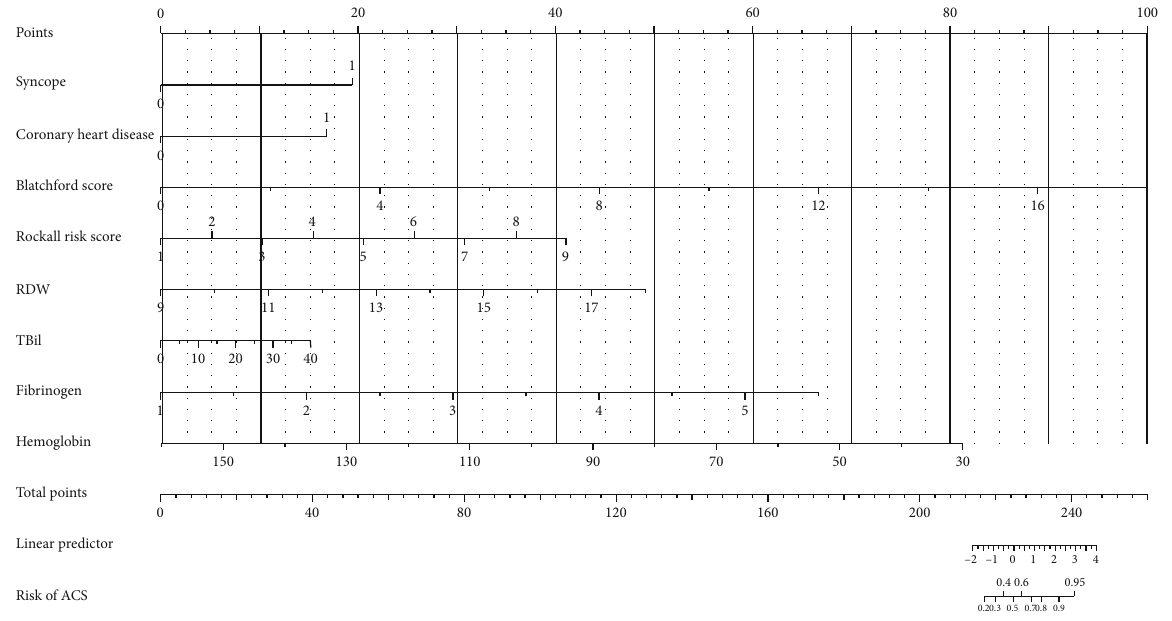
Figure 1: The nomogram of the multivariate logistic regression model. A nomogram can simplify statistical predictive models into a single numerical estimate of the probability of ACS occurrence in the form of a graph. In a nomogram, the value of each patient is located on the axis of variables, and a straight line is drawn upward to determine the point value of each variable. For example, a patient can get 0 point if he has no syncope syndrome and get about 45 points if his Blatchford score is 8. Finally, the total point of this patient is obtained by summing the point values identi fi ed on the scale for each variable in the model. If the total point of this patient is 220, the probability of ACS occurrence can be predicted as 20% ~ 30% by a perpendicular line extending downward to “ Risk of ACS ” axis from 220 on the “ Total points ” axis.